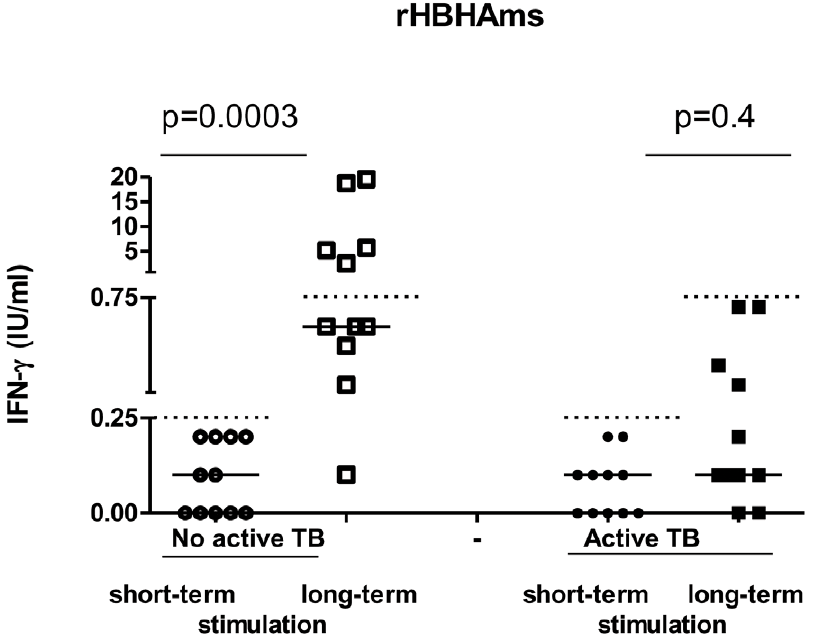
Figure 5. Memory responses to rHBHAms. Memory response (long-term stimulation) to rHBHAms was evaluated in the subjects who scored negative on the short- test. A significant difference was found between the IFN- c value obtained in the short-term stimulation compared to the long- term stimulation among those without active TB (p=0.0003). Differently, no significant difference was found between the short- and long- term stimulation among those with active TB (p=0.4). The data are shown after the subtraction of the results obtained in the unstimulated samples. Dotted lines indicate the cut-off obtained for the short- and long-term tests.